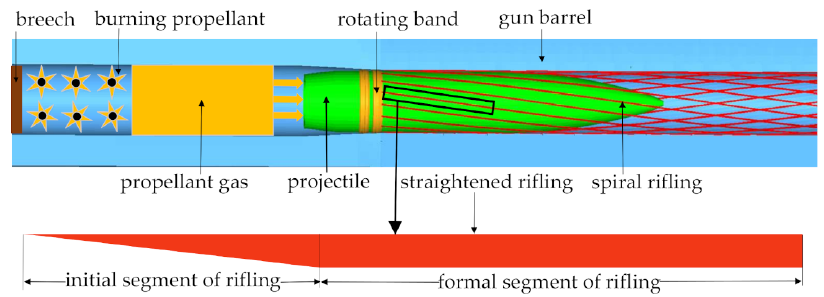
Figure 4. Schematic diagram of the engraving process and exhibition of straightened